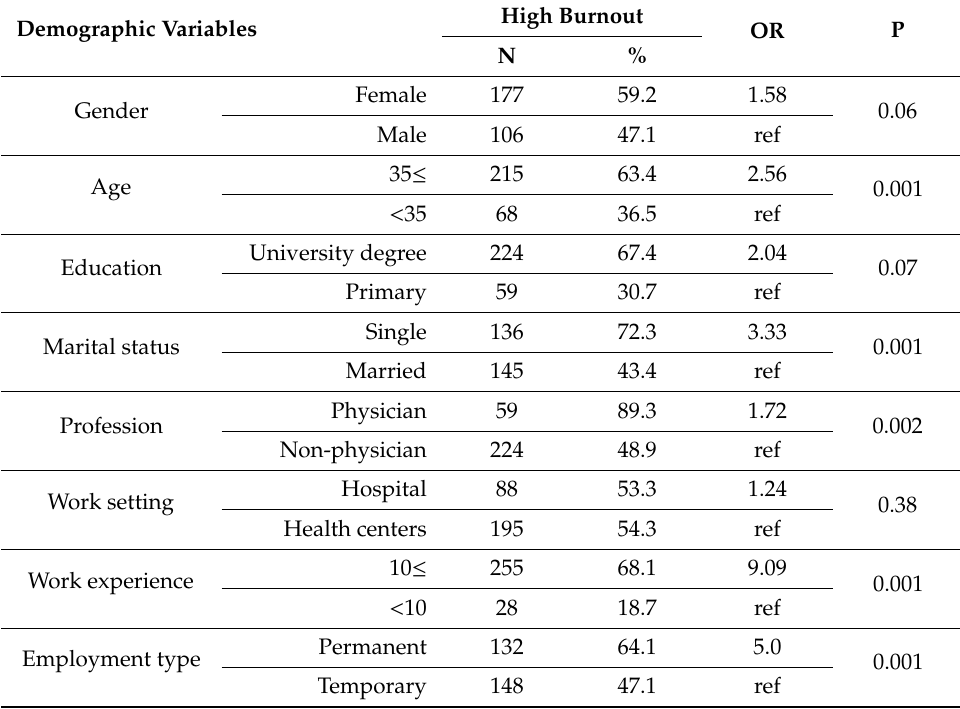
Table 5. Logistic regression: Predictors of high